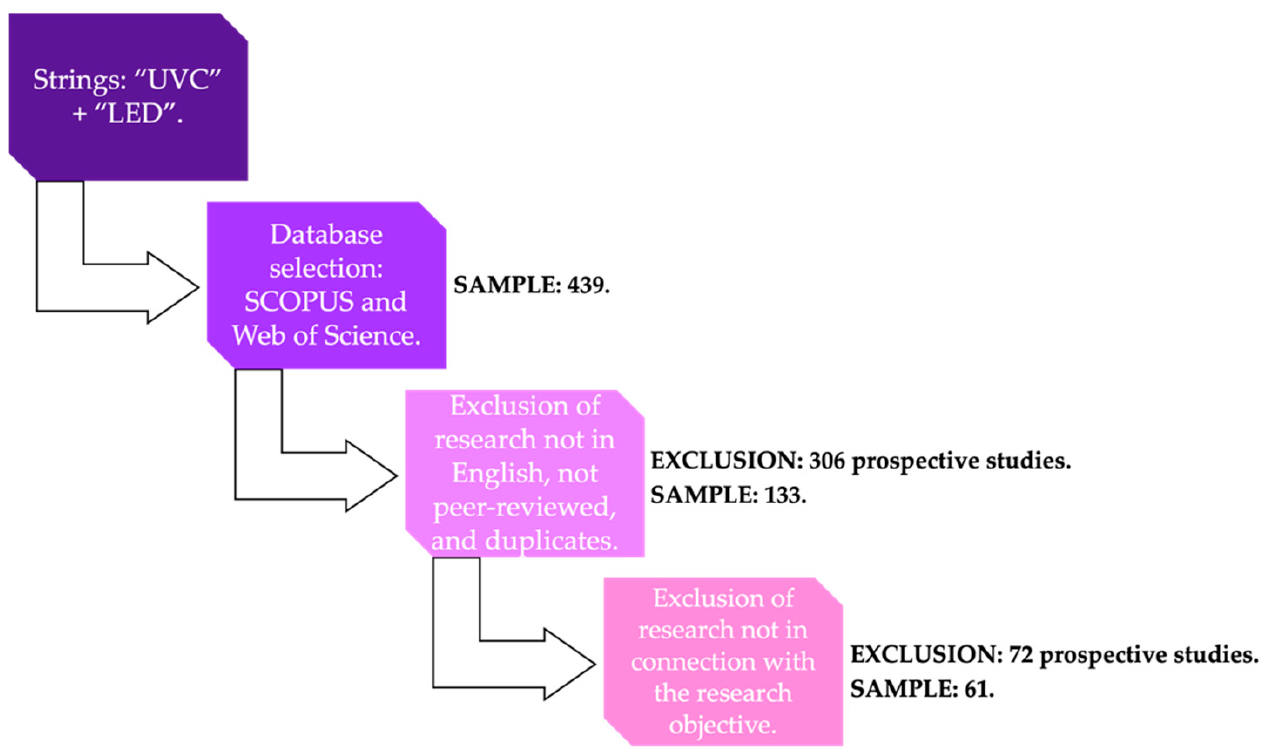
Figure A1. SLR Figure A1. SLR steps.